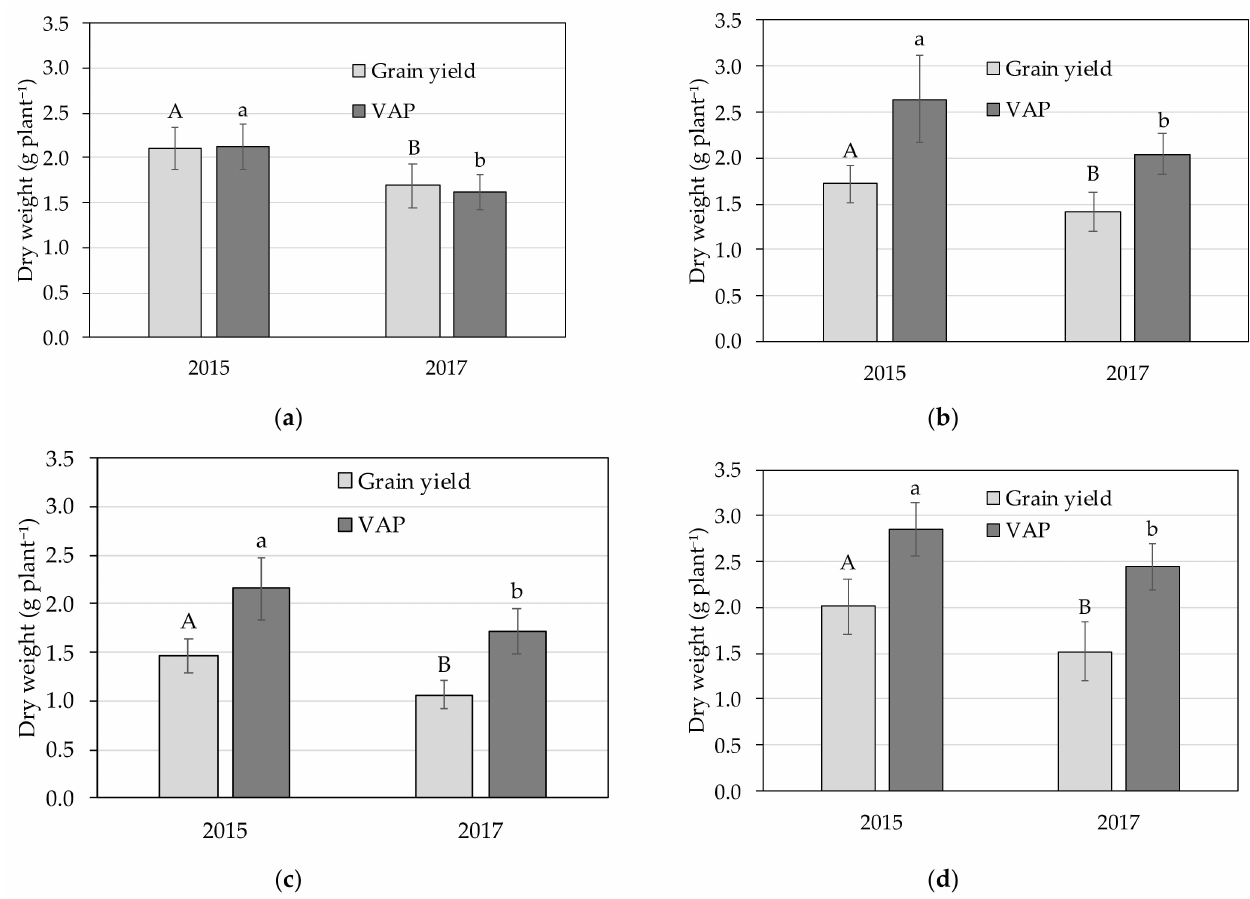
Figure 2. Biomass (DW g plant − 1 ) of vegetative aboveground plant parts (VAP) and grain yield, as affected by year treatment in: ( a ) barley; ( b ) common wheat; ( c ) durum wheat; and ( d ) oat. Bars with different letters are significantly different according to Tukey’s test ( p > 0.95); uppercase letters refer to grain yield and lowercase to VAP. Error bars represent standard